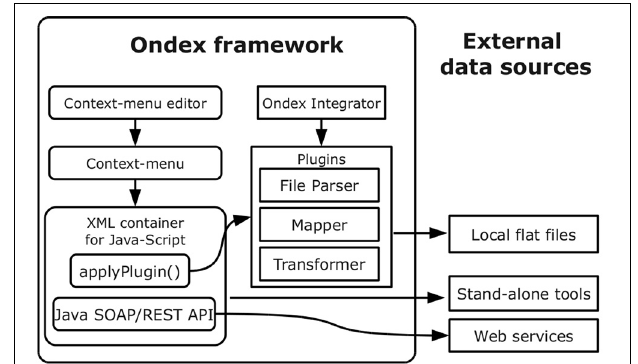
FIGURE 2 | Simplified modular view of context menu extension. The new Ondex framework extension realizes context-sensitive menus which can be edited with the help of a GUI based editor. Concept specific entries are implemented in XML-files that contain Java Script code. Existing plug-ins for data integration from the Ondex library can be directly invoked. Web services and local installations of external programs can be called from the context